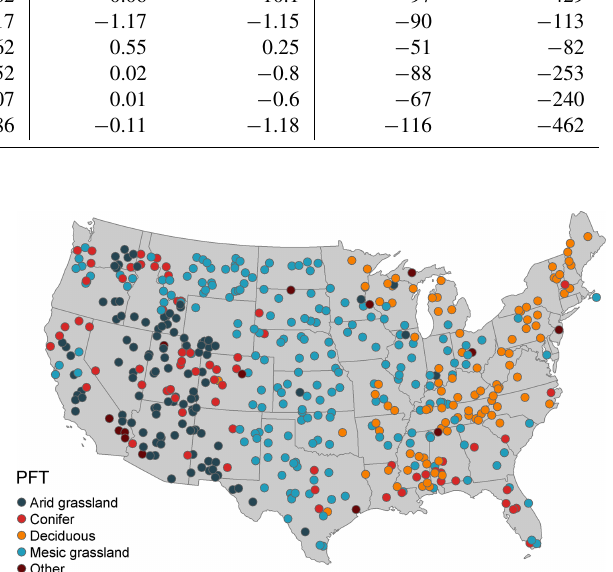
Figure 2. Distribution of sites with their corresponding plant func- tional type across CONUS.